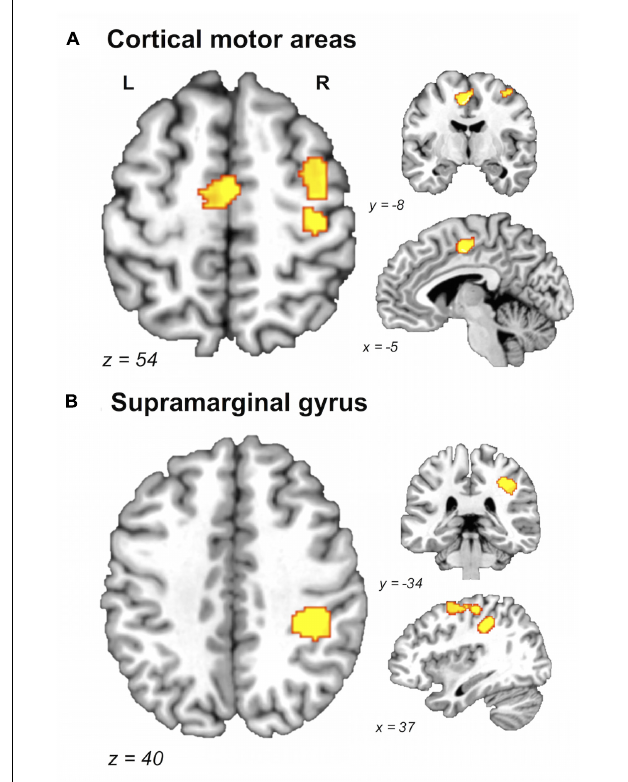
FIGURE 2 | Brain areas showing greater likelihood of activation in older compared with young adults. Whole-brain ALE maps for the older > young adult contrast (voxel-wise FDR correction at p < 0.05, k > 100 mm 3 ). Suprathreshold ALE values were observed in right primary sensorimotor cortex, right dorsal premotor cortex, and supplementary motor area (A) , and right supramarginal gyrus (B) . L, left hemisphere; R, right hemisphere. Table 5 provides the full list of ALE peaks for this map.